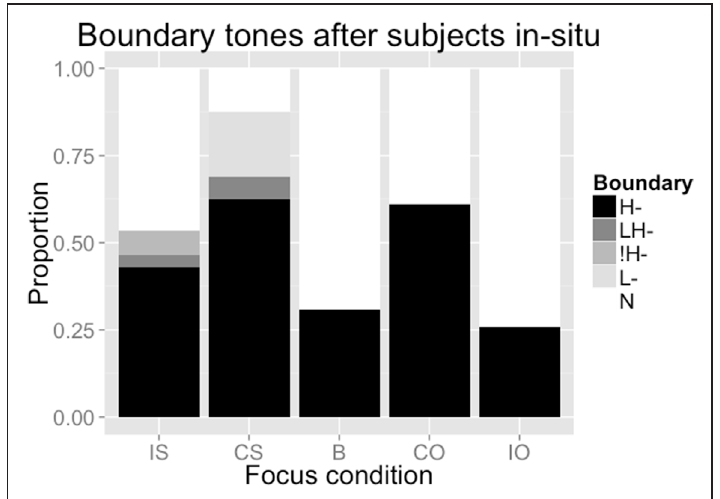
Figure 4: Proportion of boundary tones used after subjects expressed in-situ in the following focus conditions: Informational subject focus (IS), contrastive subject focus (CS), broad focus (B) or non-focused in contexts of contrastive object focus (CO) and informational object focus (IO).